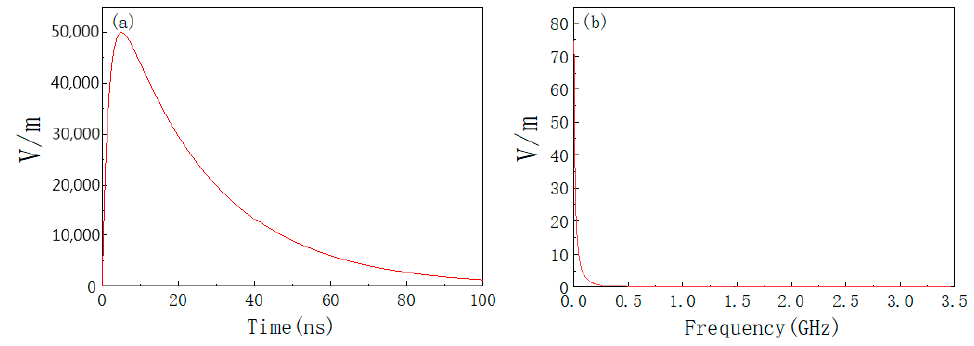
Figure 13. NEMP waveform. ( a ) Time domain; ( b ) frequency domain.